Question: Does the figure show an increasing or a decreasing trend?
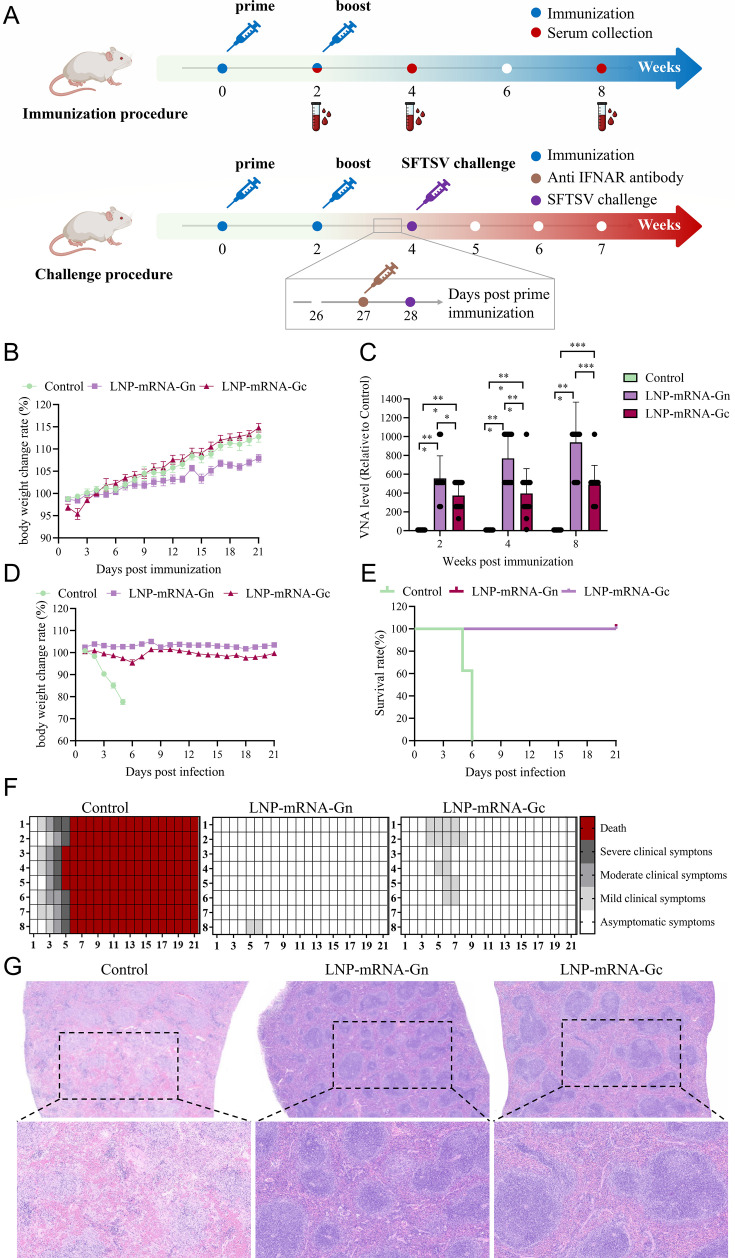
Answer: increasing